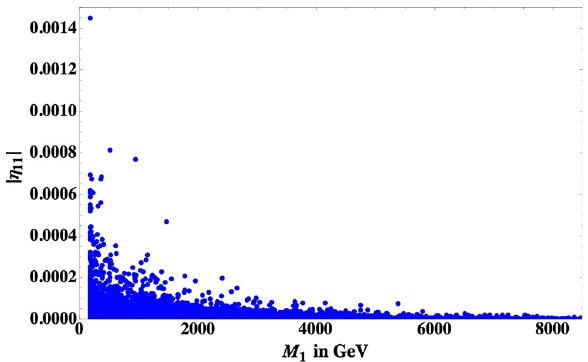
Fig. 4 | η 11 | deviations from unitarity as a function of M 1 , generated under the condition that Tr ( mm † ) ≤ m 2 t and | η 12 | ≤ 2 × 10 −